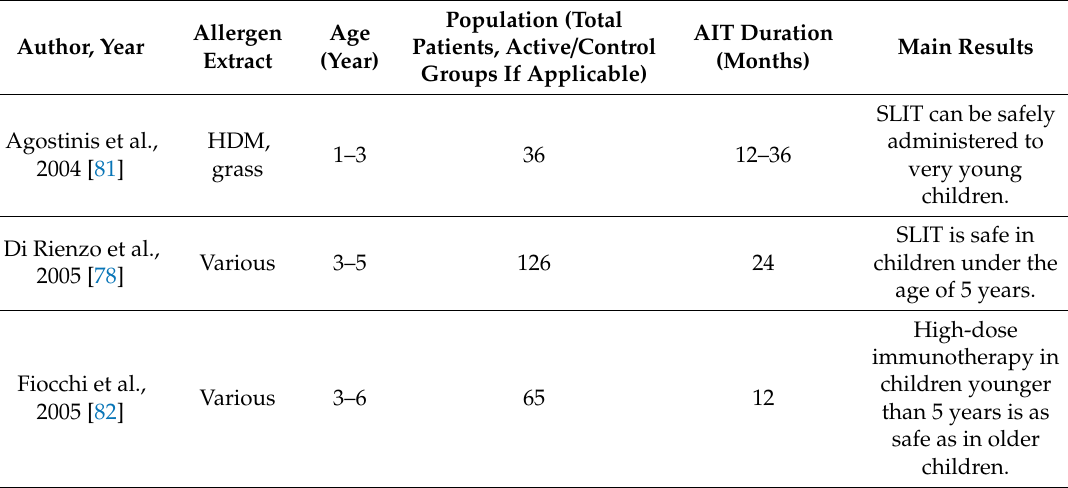
Table 3. Studies evaluating safety of sublingual immunotherapy in young